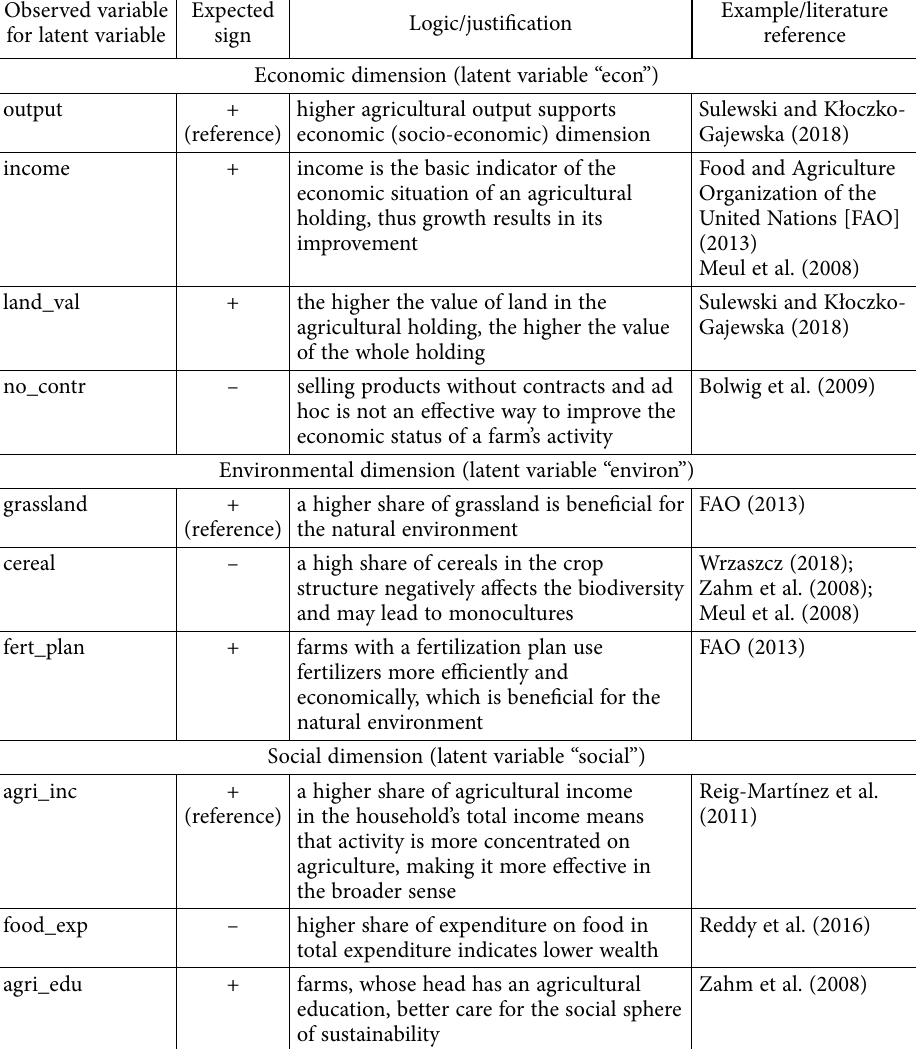
Table 1. Metrics for latent variables and their justification Observed variable for latent